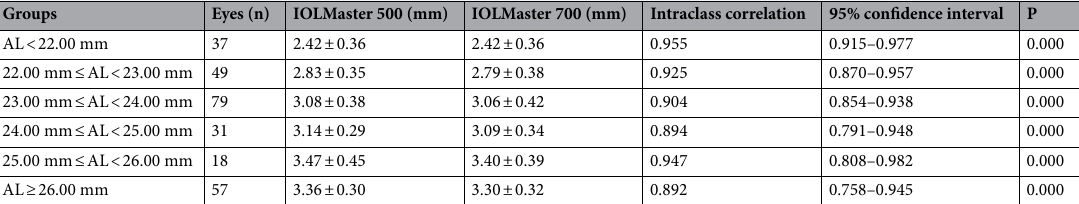
Table 5. The results of IOLMaster 500 and IOLMaster 700 in ACD measurement and ICC